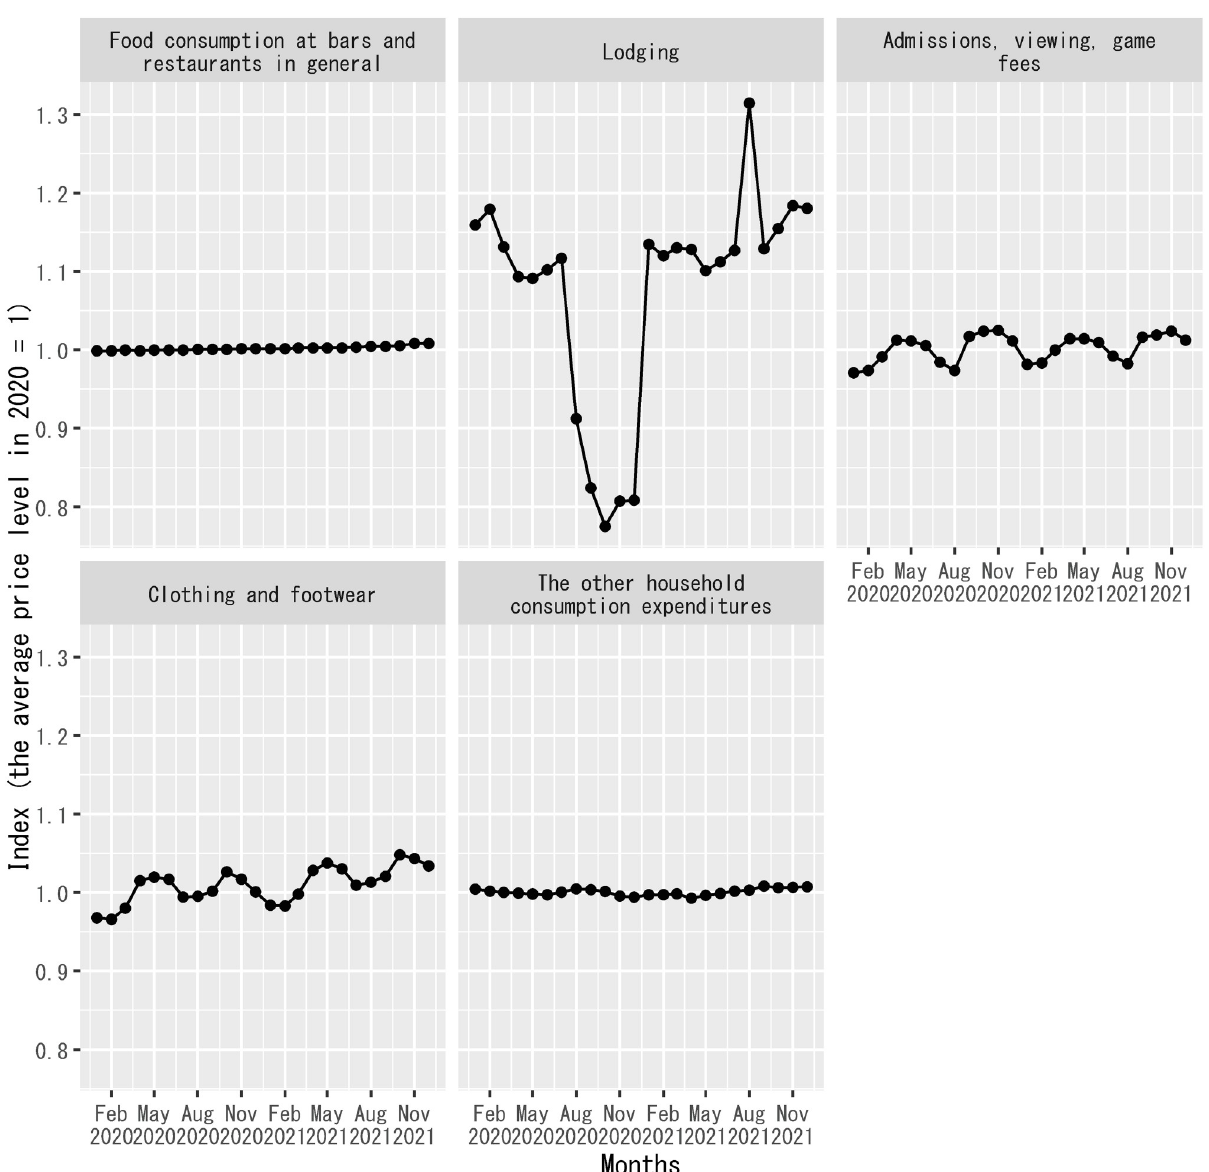
Fig 1. Price levels of classified components of household expenditures in Japan. This figure shows the monthly values of the consumer price index related to each component of household expenditures included in the explanatory variables. The sample period shown in the figure is from January 2020 to December 2021. The index for lodging includes both the prices of non-packaged lodging and the costs of accommodation in domestic travel packages. The index for food consumption at bars and restaurants in general covers the prices of three types of food consumption at bars and restaurants included in the explanatory variables. There are no separate consumer price indices corresponding to non-packaged lodging, domestic travel packages, and the three types of food consumption at bars and restaurants in the data source [51].